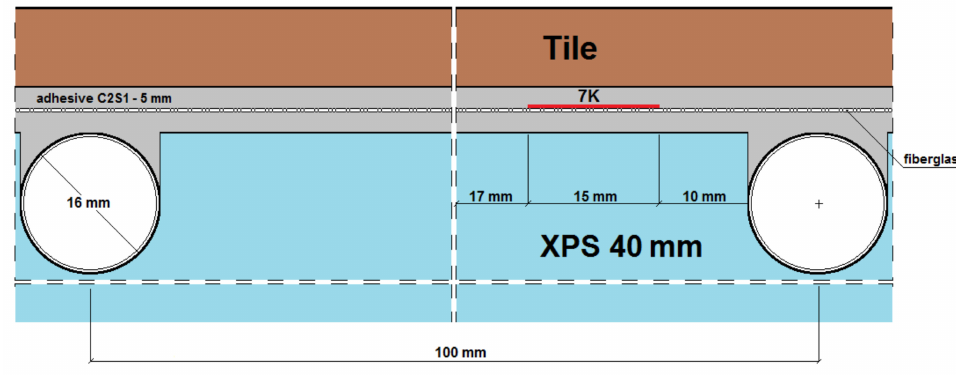
Figure 10. Vertical section IV–IV of the research model with C2S1 adhesive, without